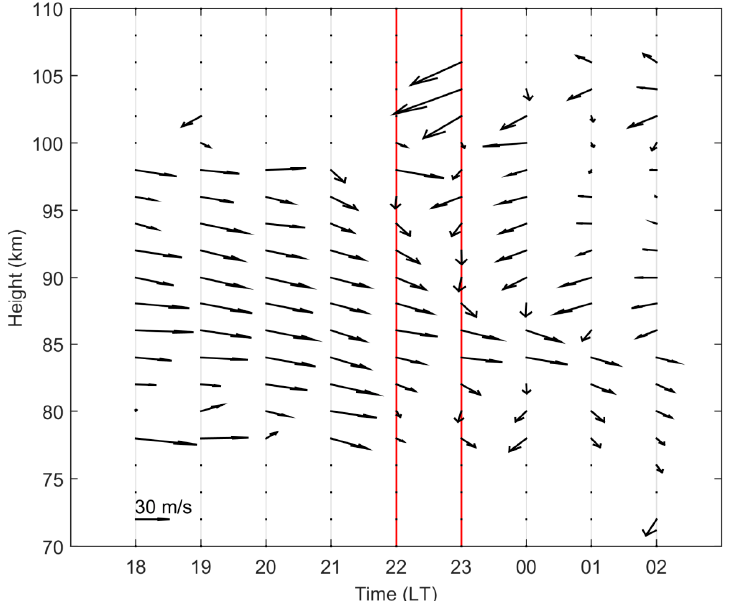
Figure 7. The vector wind profile on the night of 10–11th August 2013. The arrow denotes the direction of the wind; upwards is north, right is east. The CGWs were measured from 22:00 LT to 23:00 LT and are shown as the red lines.